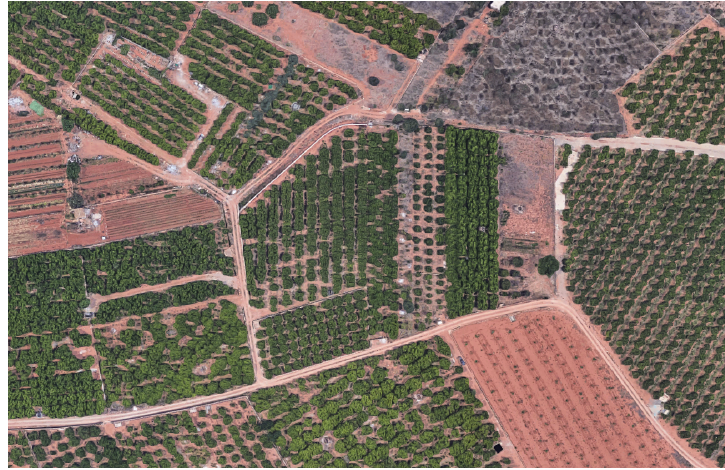
Figure 1. Sample of small farms, including abandoned ones, in Valencia